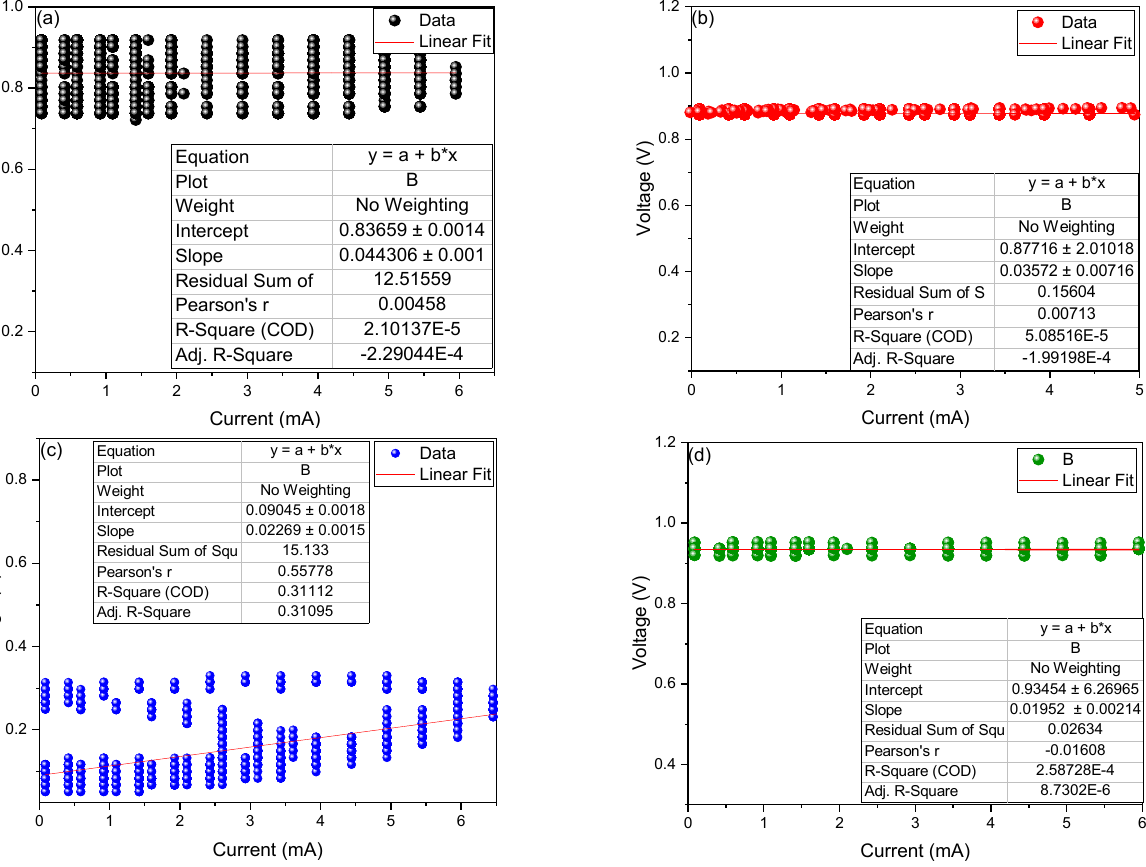
Figure 2. Internal resistance values of the microbial fuel cells at ( a ) 0, ( b ) 5, ( c ) 10 and ( d ) 20% sucrose. Figure 3 shows the values of power density (PD) and maximum voltage as a function of current density (CD), being the MFCs with 20% sucrose the one that generated a higher value of PD with 583.09 mW/cm 2 at a CD of 407.13 A/cm 2 and a peak voltage of 910.94 mV; generated a PD of 427.14 mW/cm 2 in a CD of 4.920 A/cm 2 with a peak voltage of 537.72